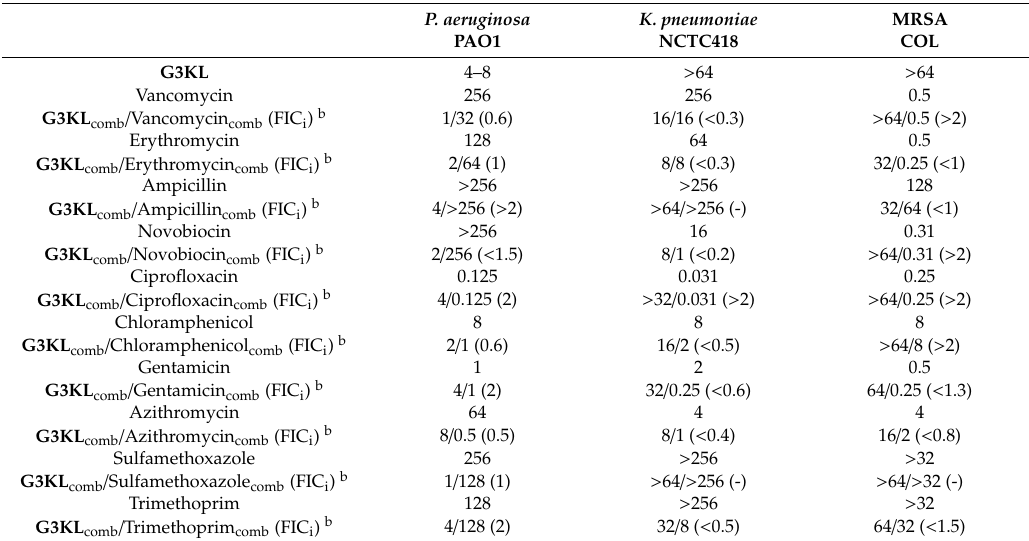
Table 2. MICs ( µ g / mL) of G3KL and small molecule drugs in combination a